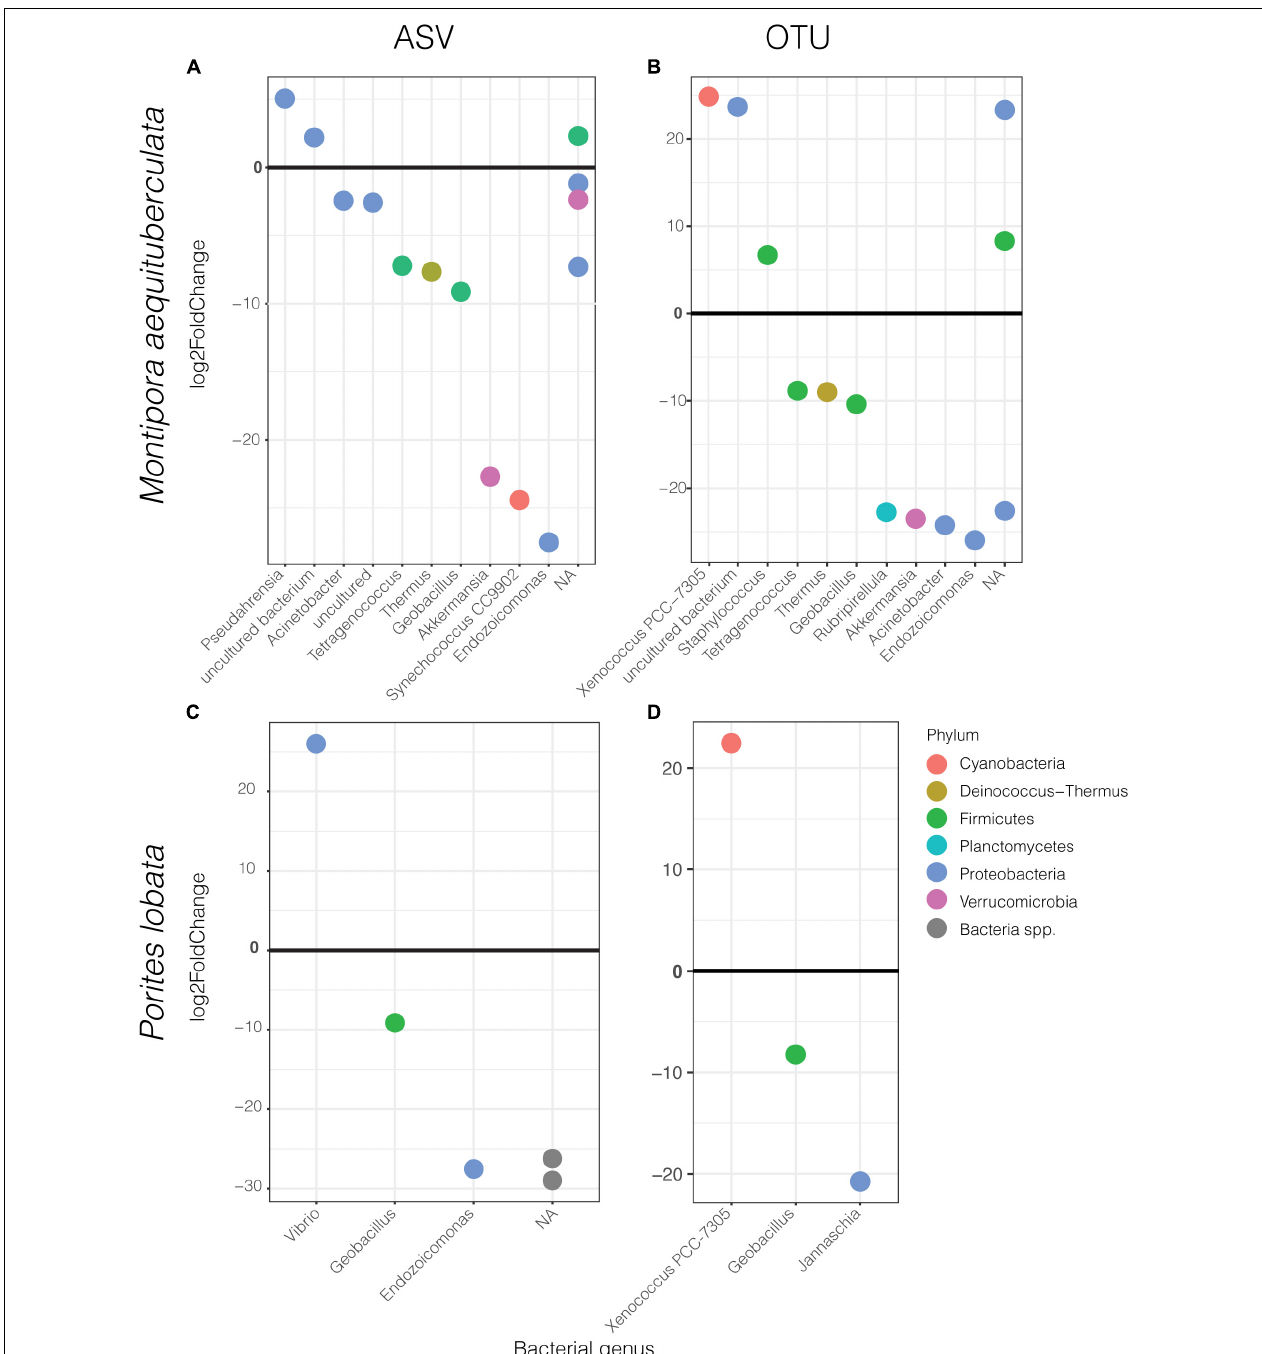
FIGURE 4 | Significantly different ASVs (left) and OTUs (right) between protocols labeled by bacterial genus and colored by phylum for M. aequituberculata (A,B) and P. lobata (C,D) . Positive log2fold change refers to those significantly enriched in MiSeq protocol samples and negative log2fold change are those significantly enriched in HiSeq protocol samples. NA refers to bacteria unclassified at genus